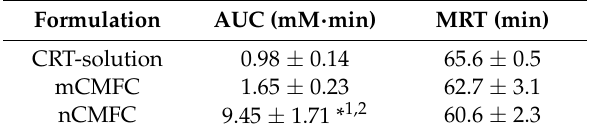
Table 2. Pharmacokinetic analysis of carteolol in the in vivo transcorneal penetration of nCMFC. Formulation